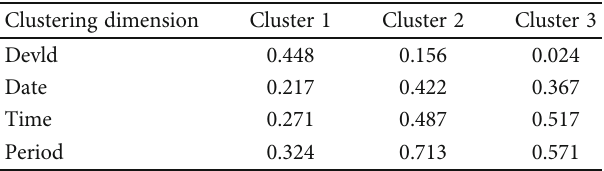
Table 4: KL divergence value when k is 3.